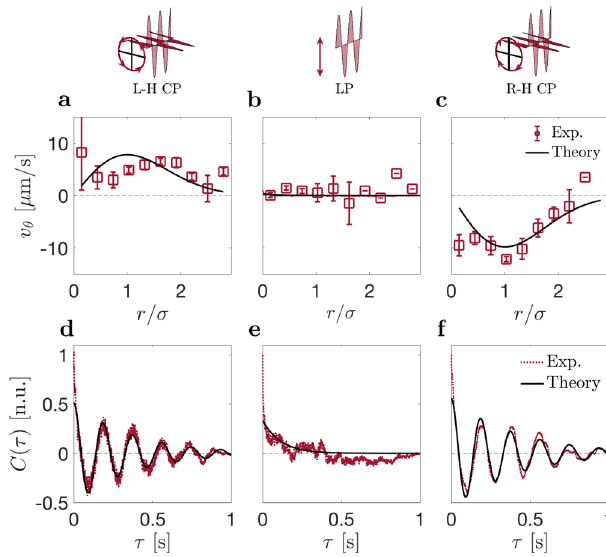
Fig. 6 Controlling the direction of orbital rotation through light polarization. The particle orbital rotation is biased toward the direction of the polarization of the trapping beam (laser power P = 1 mW, nanoparticle radius a = 100 nm). a – c Experimental values (red symbols) and theoretical fi ts (black lines) of the azimuthal velocity v θ : a for left-handed circular polarization, v θ > 0 showing counter-clockwise orbital rotation of the particle; b for linear polarization (see also Figs. 1 and 2), v θ ≈ 0 showing no preferred direction of rotation; and, c for right-handed circular polarization, v θ < 0 showing clockwise orbital rotation. Error bars are the standard error of the mean. The solid line is calculated from Eq. (7) with Ω the same as in a – c , and taking D r = 70 s − 1 , K = 1.27 × 10 − 16 J W − 1 (corresponding to about 30 k B T c per 1 mW), u 0 = 120 μ m s − 1 , and P c = 0.2 mW. d – f Experimental (red lines) and theoretical fi ts (black lines) of the scattering autocorrelation C ( τ ) as a function of lag time τ . The absolute value of the spinning frequency Ω is d ∣ Ω ∣ = 2.7 Hz for left-handed circular polarization, e ∣ Ω ∣ = 0 Hz for linear polarization, and f ∣ Ω ∣ = 2.7 Hz for right-handed circular polarization. The absolute value of the decay constant is d τ 0 = 0.37 s for left-handed circular polarization, e τ 0 = 0.11 s for linear polarization, and f τ 0 = 0.41 s for right-handed circular